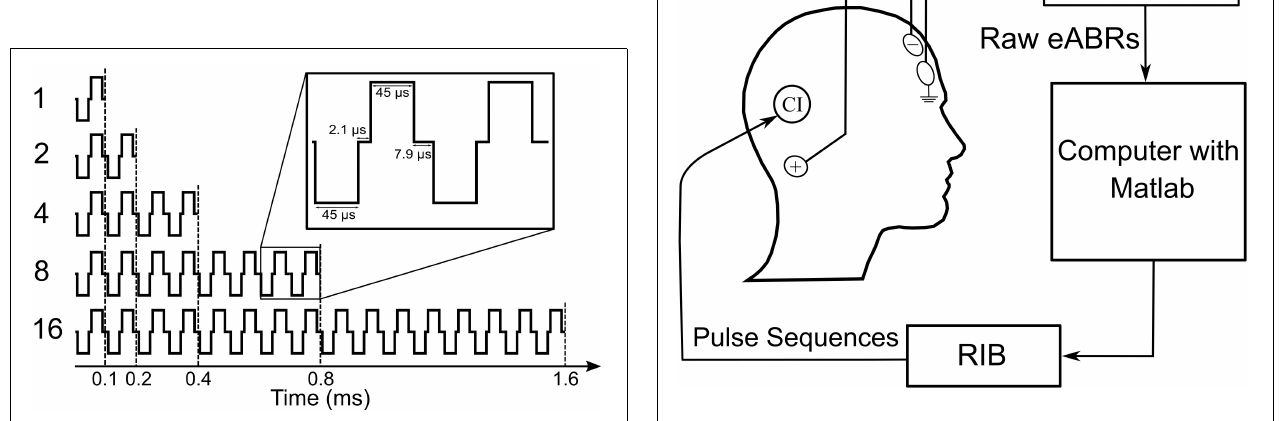
FIGURE 3 | eABR multi-pulse measurement conditions ( n.m. means not